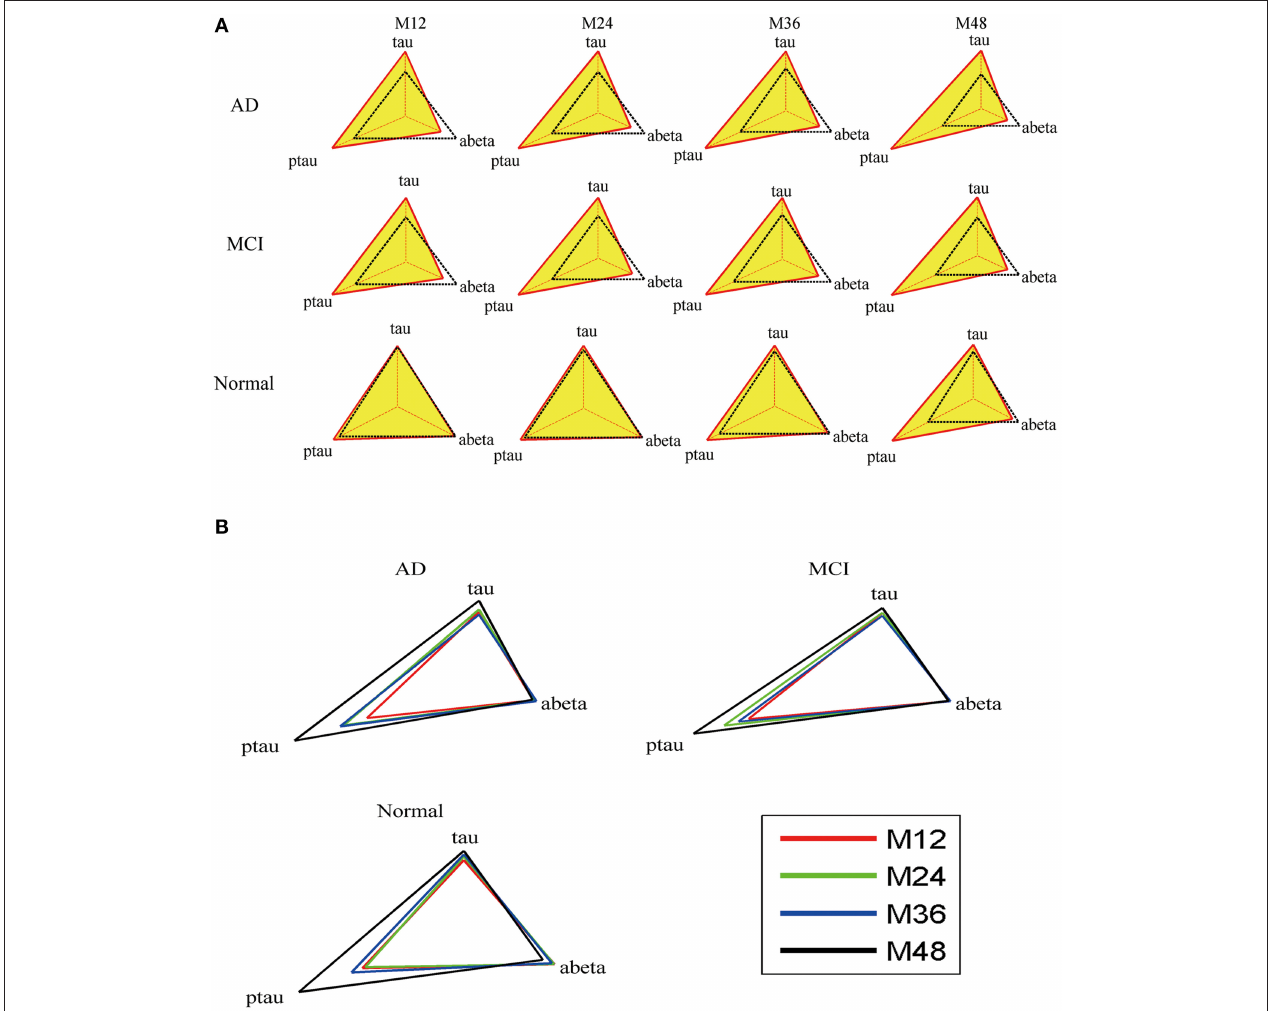
FIGURE 6 | Mini network balance map of AD based on CSF biomarkers panel. (A) Mini network balance maps for the three groups at different time points. (B) Longitudinal mini network balance maps for the three groups. In normal state, the shape of mini network balance map is equilateral triangle. With the shape deformation, the mini network imbalance gets